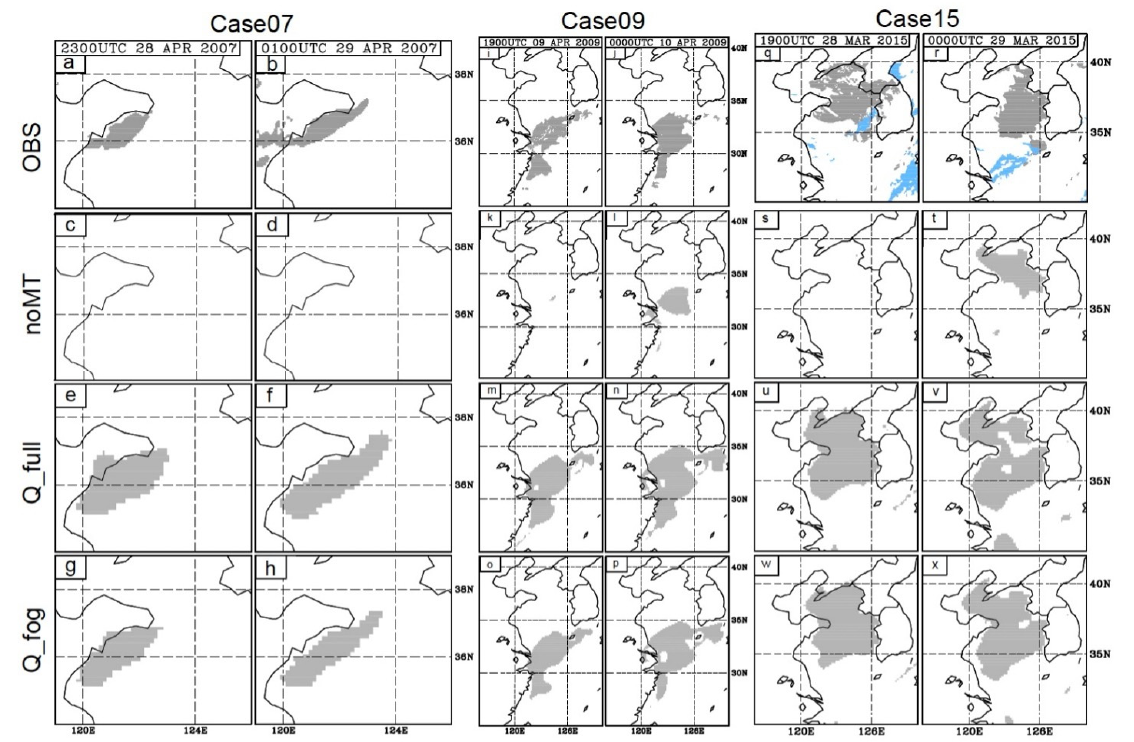
Figure 11. Observed sea fog area (OBS) for ( a , b ) Case07, ( i , j ) Case09, and ( q , r ) Case15, and forecasts from continuously cycled DA experiments for ( c , d , k , l , s , t ) noMT, ( e , f , m , n , u , v ) Q_full, and ( g , h , o , p , w , x ) Q_fog. For Case07, ( c – h ) forecasts are initialized at 2100 UTC 28 April. For Case09, ( k – p ) forecasts are initialized at 1800 UTC 9 April. For Case15, ( s – x ) forecasts are initialized at 1800 UTC 28 March. The light blue shadings in ( q , r ) show the observed high clouds. The 2 ‐ and 4 ‐ h forecasts initialized at 2100 UTC 28 April 2007 for Case07 are shown